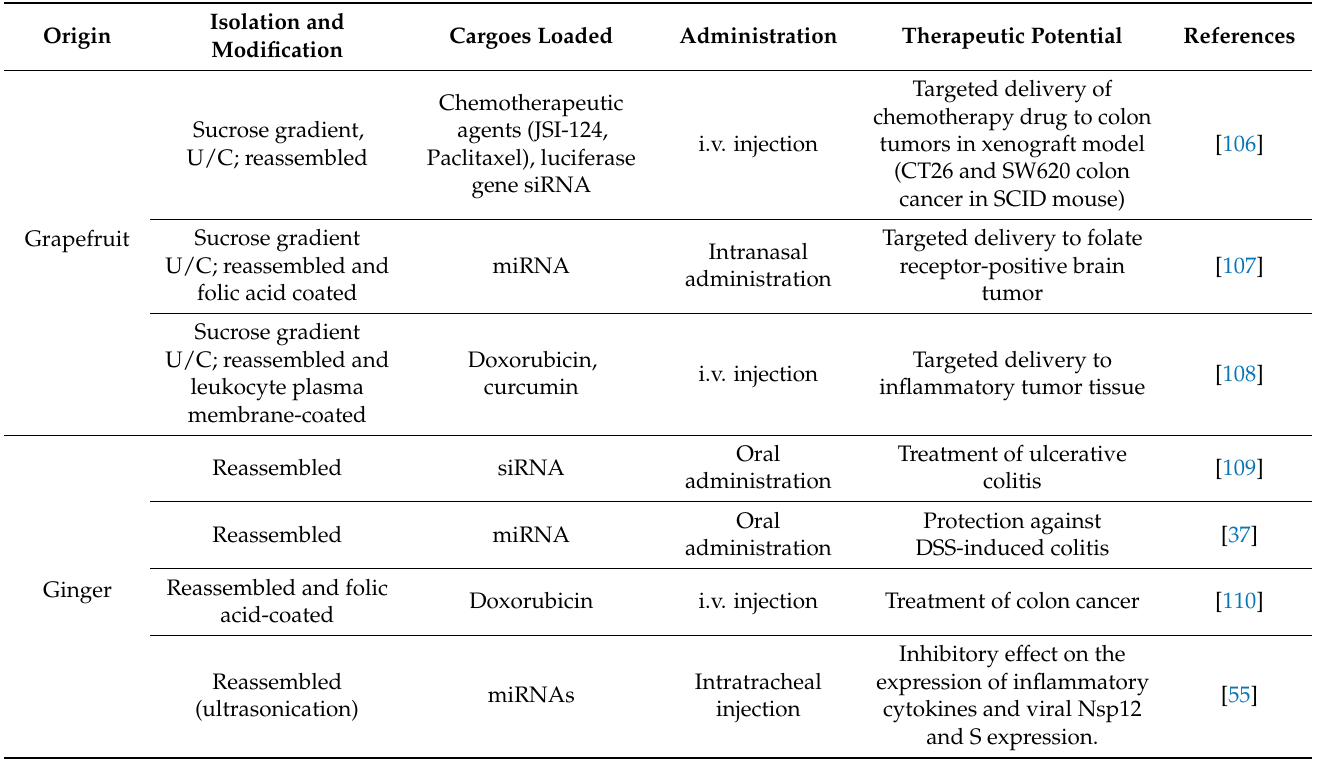
Table 4. Nanoparticles made of plant-derived